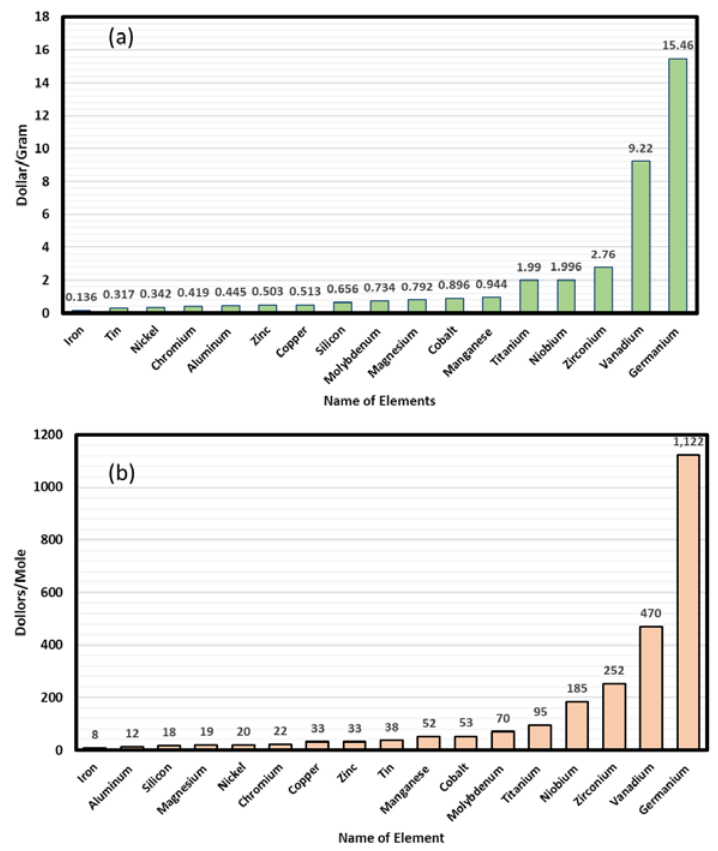
Figure 1. ( a ) Cost / gram of di ff erent metal powder to be used for additive manufacturing. ( b ) Cost / mole of di ff erent metal powder to be used for additive manufacturing.